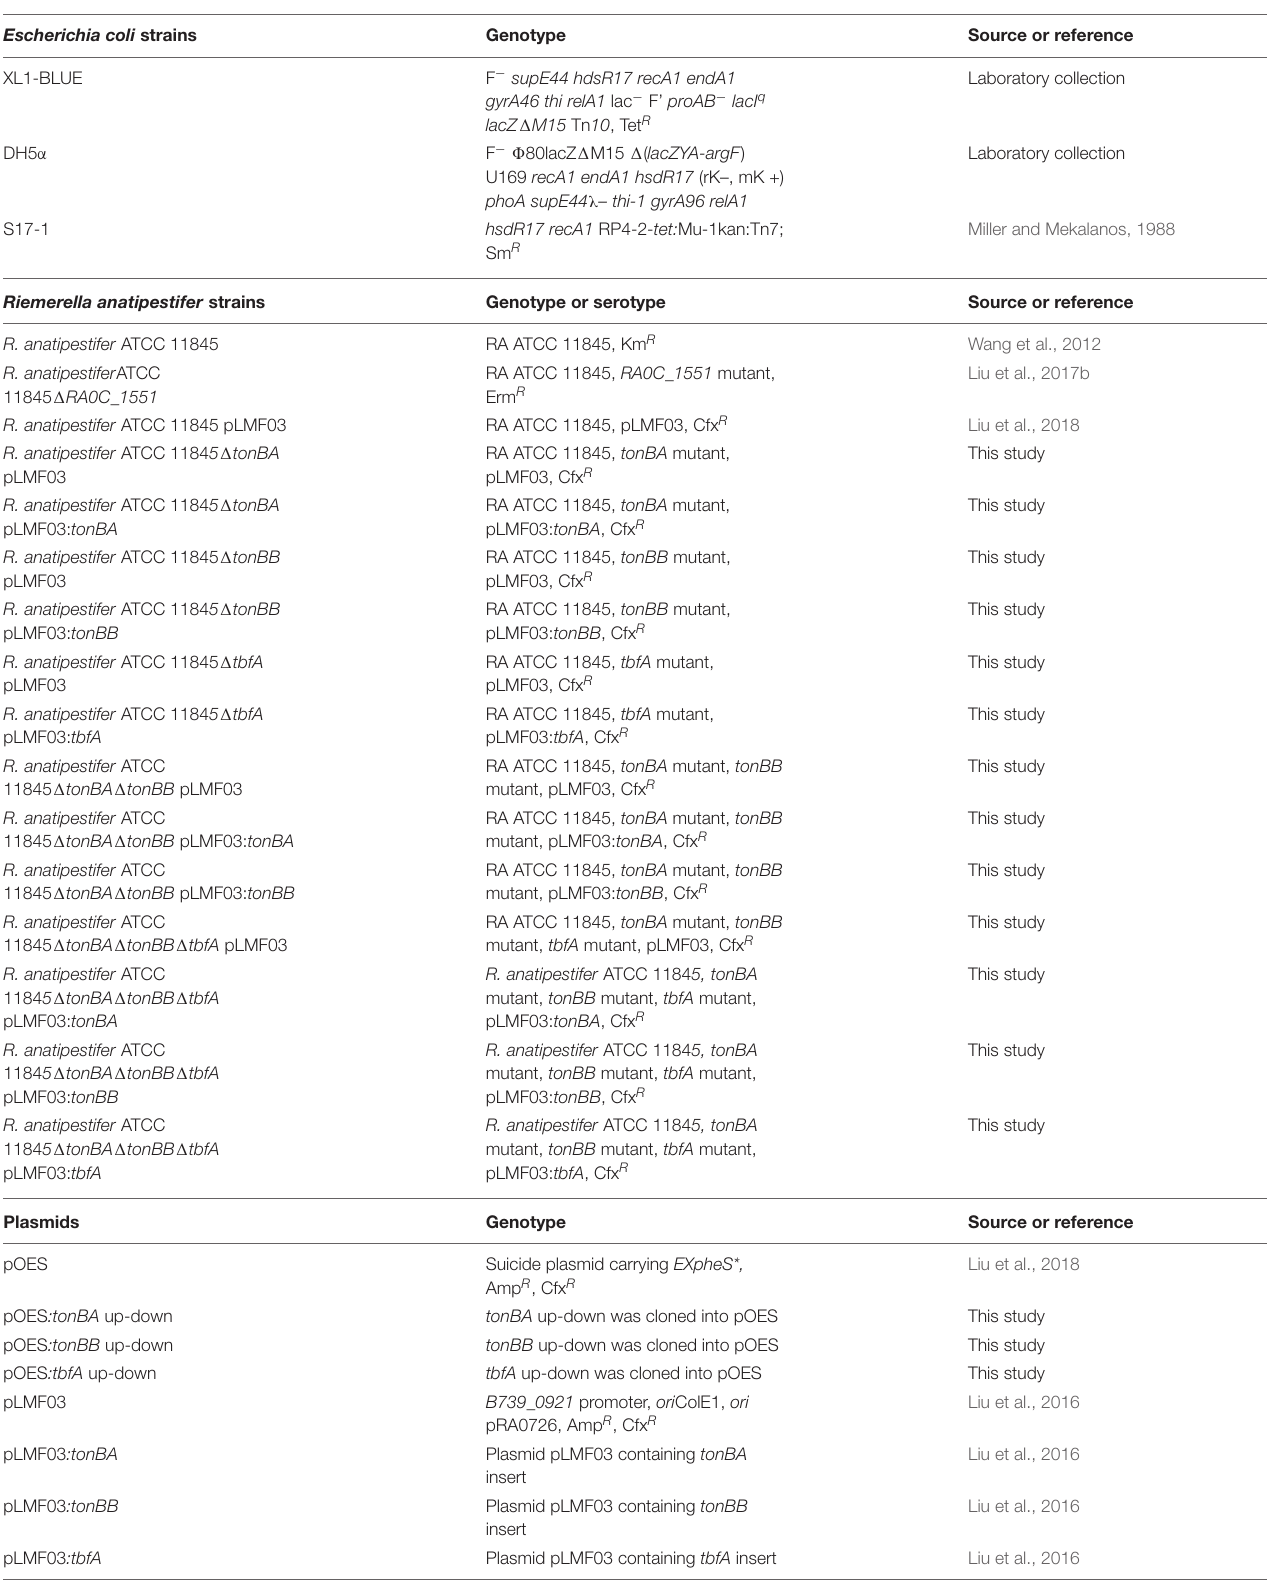
TABLE 1 | Strains and plasmids used in this